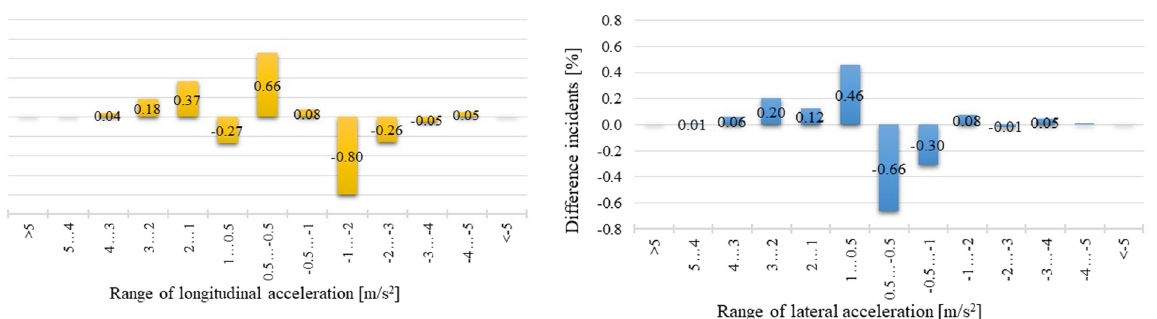
Figure 14: The di ff erence in the frequency of occurrence of particular values of lateral acceleration of the afternoon drive in relation to the morning drive.